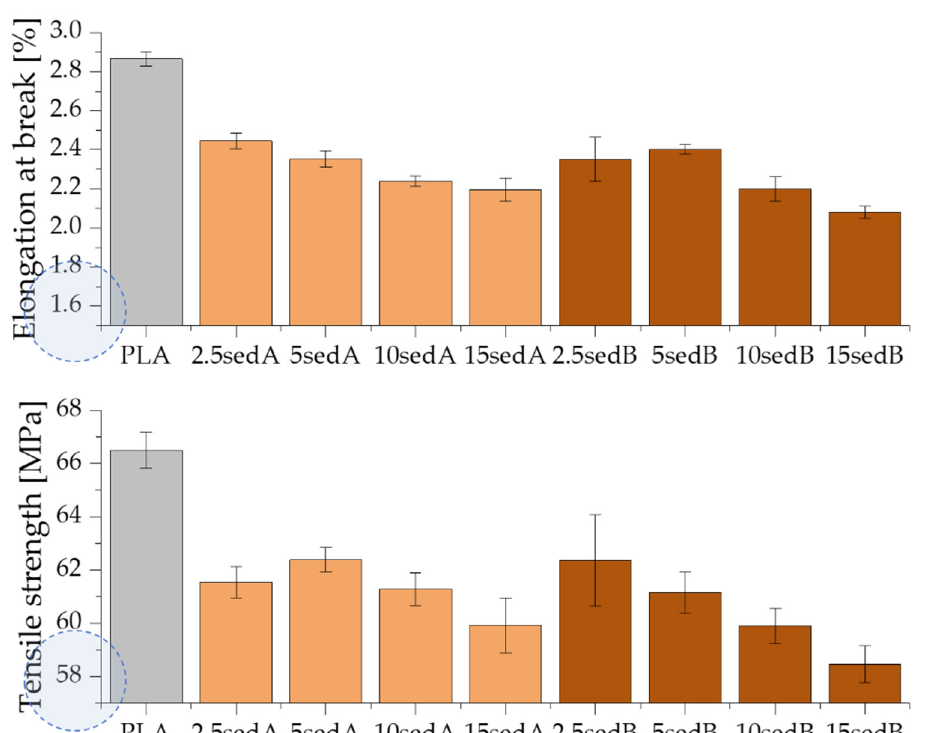
Figure 10. Tensile strength and elongation at break for PLA/sedA-B composites.